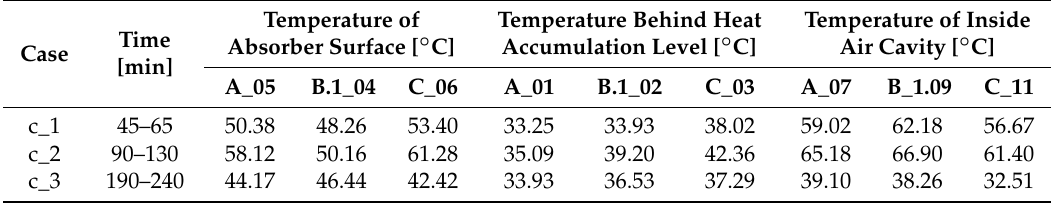
Table 7. Summary of temperatures averaged on proposed